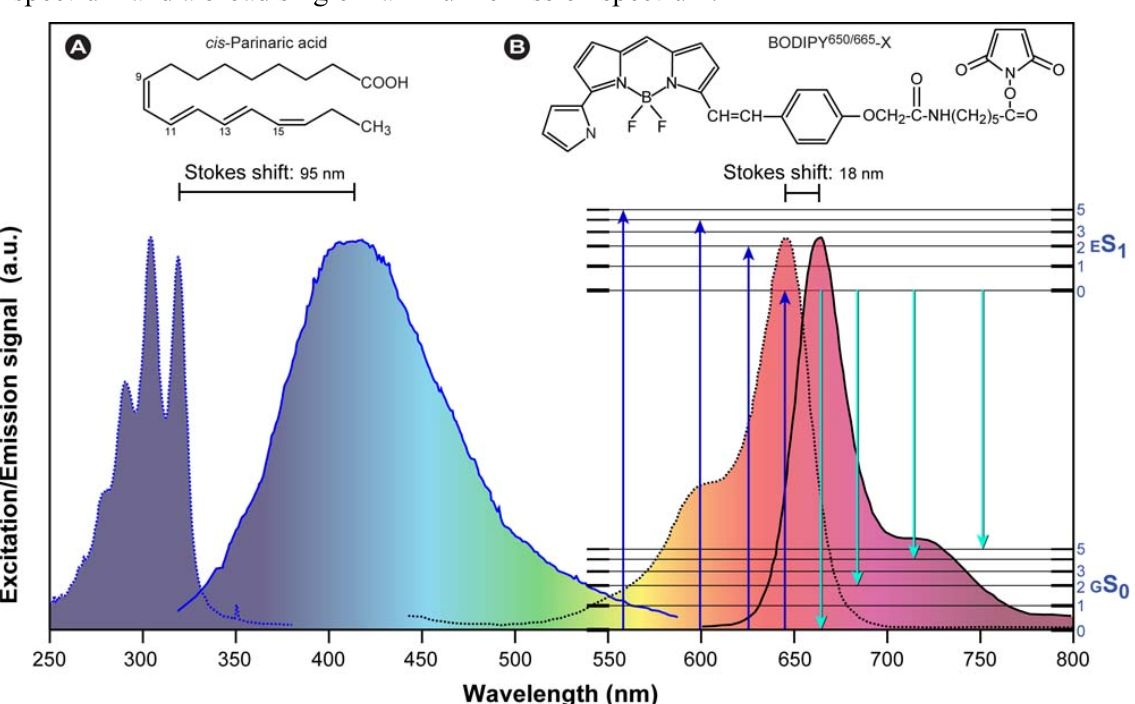
Figure 3. Stokes shift and mirror image rule. This diagram shows typical absorption/ excitation and emission spectra of two different fluorescent dyes: ( A ) cis -Parinaric acid; ( B ) BODIPY 650/665 . The difference between the excitation and emission maxima is called “Stokes shift”. It is caused by a quick electron relaxation and intramolecular vibrational energy loss taking place between the different excited state sublevels. That is the reason why the excitation light normally has a shorter wavelength ( i.e. , higher energy) than the emission light ( i.e. , lower energy). In many fluorochromes, the same electronic transitions are involved in both excitation and emission, which leads to near-mirror image spectra. This is not always the case, as exemplified by cis -parinaric acid ( A ), which characteristically shows four maxima, corresponding to the four conjugated double bonds in the absorption spectrum and a broad single maximum emission